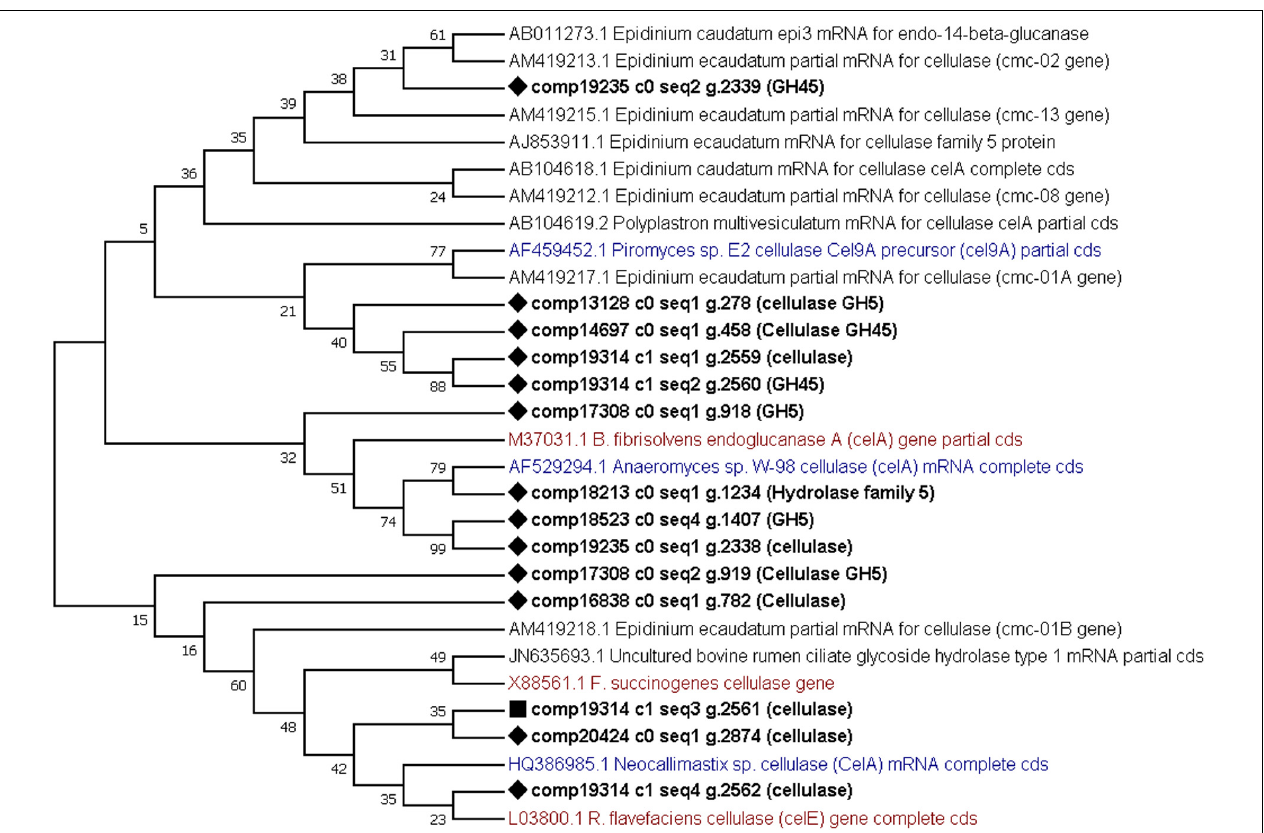
FIGURE 5 | Comparative phylogenetic tree of all putative cellulase (or GH5) genes detected within the protozoal metatranscriptome. Twelve representative protozoal sequences from Epidinium ecaudatum (6) , Epidinium caudatum (4) , Polyplastron multivesiculatum, (1) and an uncultured bovine rumen ciliate (1), three fungal cellulases produced by Neocallimastix sp. , Piromyces sp. and Anaeromyces sp. and three bacterial cellulases from Ruminococcus flavefaciens, Butyrivibrio fibrisolvens and Fibrobacter succinogenes are given for comparison. Target sequences from the metatranscriptome are shown in bold with a diamond shape node marker, the most highly expressed enzyme is marked with a square, protozoal sequences are given in black, bacterial in red and fungal in blue